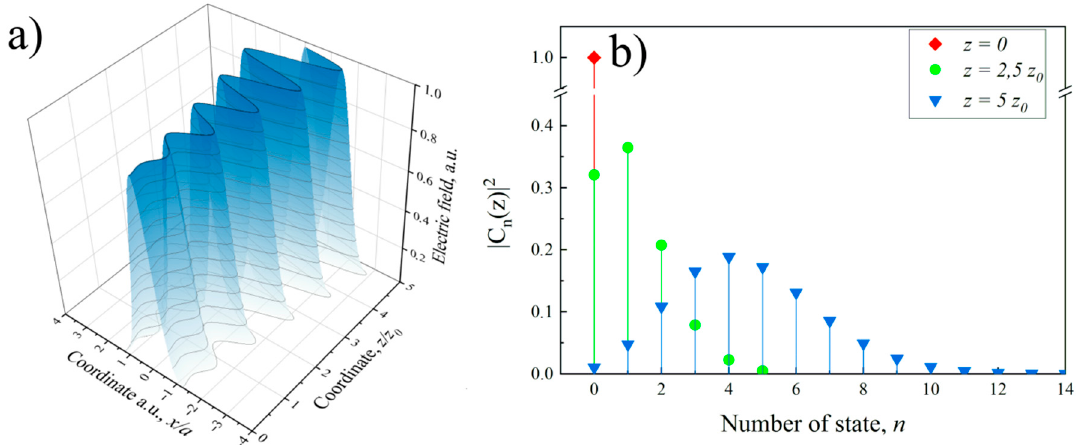
Figure 4. Excitation of the coherent state of the spatial transverse modes of the beam propagating in the waveguide modulated along the propagation direction susceptibility. ( a ) Squared amplitude of the electric field strength. ( b ) Distribution over stationary states for different lengths of propagation for z / z 0 = 0; 2.5; 5, parameter Θ coh = 2 π k γ az 0 / x 0 =